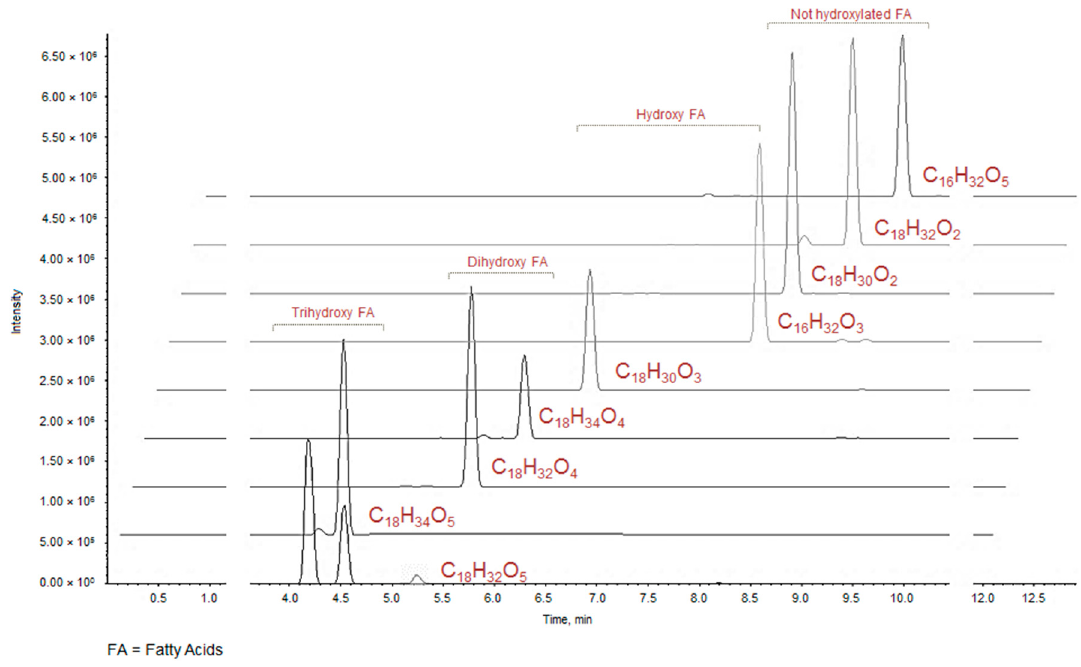
Figure 2. XIC chromatograms of fatty acids tentatively identified in ZLF-O fraction.